Question: Which kind of chart has been used to present this data?
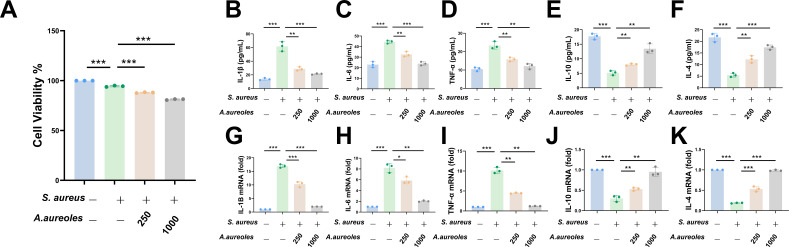
Answer: bar